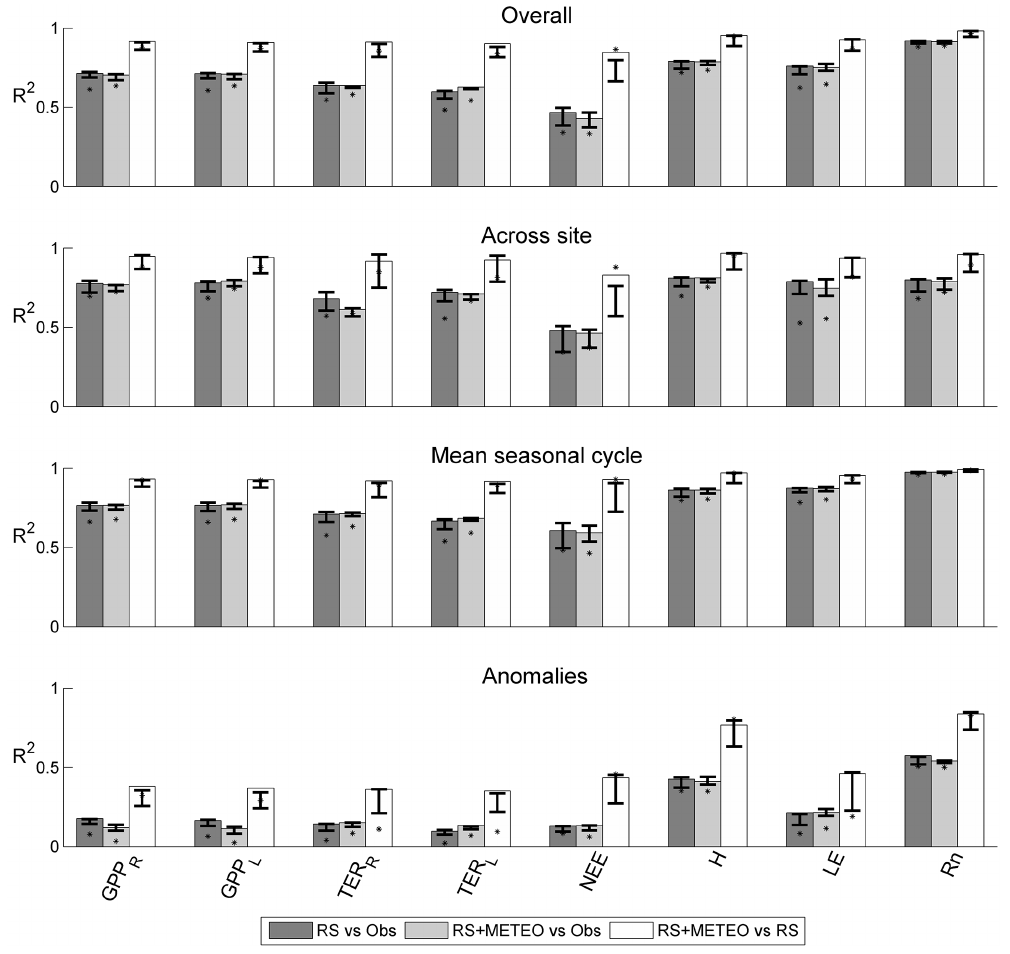
Figure 2. Coefficients of determination ( R 2 ) from the comparison of overall time series, across-sites, mean seasonal cycle, and the anomalies, in particular the determination coefficients between predictions by the ensemble median estimate of RS setup and observation (dark grey bars), between predictions by the ensemble median estimate of RS + METEO setup and observation (light grey bars), and between the two ensembles’ median estimate (white bars). Whiskers were the higher and lower R 2 when the comparisons were made among the singular ML. The comparison of output by the multiple regressions was also shown (black points). GPP R and GPP L were, respectively, the gross primary production estimated following Reichstein et al. (2005) and Lasslop et al. (2010), TER R and TER L the total ecosystem respiration estimated following Reichstein et al. (2005) and Lasslop et al. (2010), NEE net ecosystem exchange, H the sensible heat, LE the latent heat and Rn the net